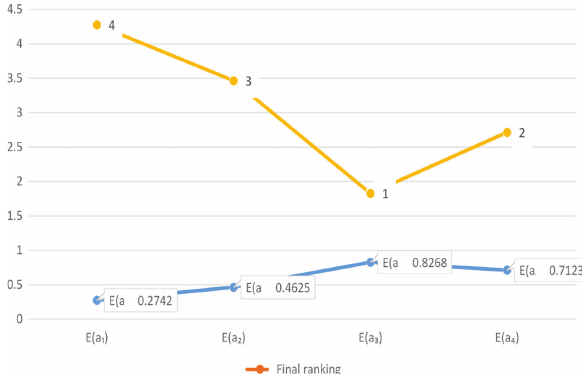
Table 8: Collective Overall Trapezoidal Cubic Fuzzy Number. a 1 a 2 a 3 a